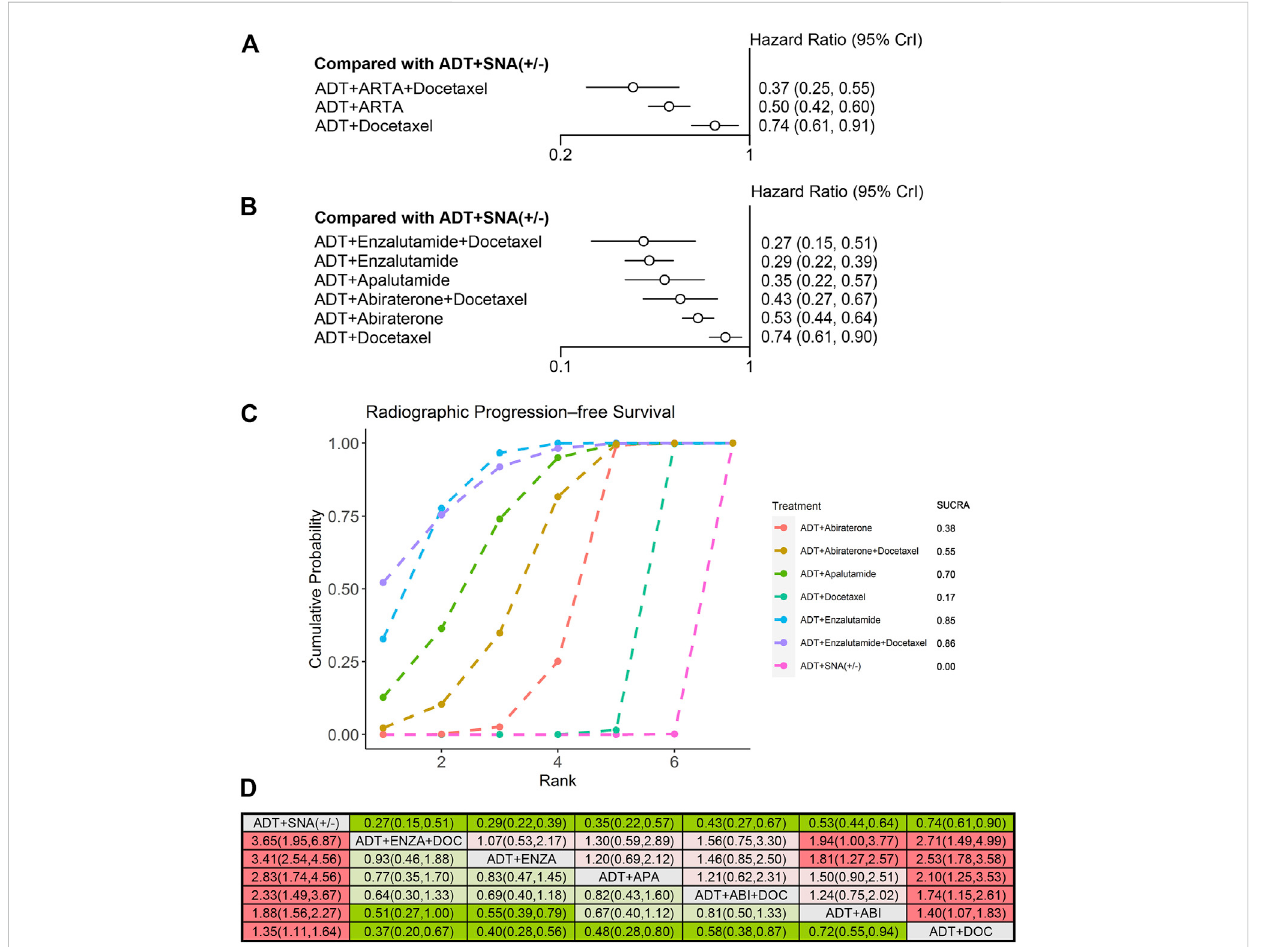
FIGURE 7 ComparisonoftherapiesforimprovingrPFSinpatientswithlow-volumedisease. (A) ForestplotrepresentingHRforcombinationtherapycompared with ADT with or without SNA. (B) Forest plot representing HR for speci fi c therapy compared with ADT with or without SNA. (C) SUCRA plot showing the treatment ranking of speci fi c therapies. (D) League table of NMA comparing the rPFS. Comparison is located at the intersection of the column-de fi ning treatment and the row-de fi ning treatment. The results are presented in HR with 95% CrI. HR > 1 (red) favors row-de fi ning treatment, and HR < 1 (green) favors column-de fi ning treatment. The dark red or green represents the results with statistical signi fi cance. DOC, Docetaxel; ABI, Abiraterone, ENZA, Enzalutamide; APA, Apalutamide; rPFS, radiographic progression-free survival; ADT, androgen deprivation therapy; SNA, standard non-steroidal antiandrogen; HR, hazard ratio; NMA, network meta-analysis; SUCRA, surface under the cumulative ranking